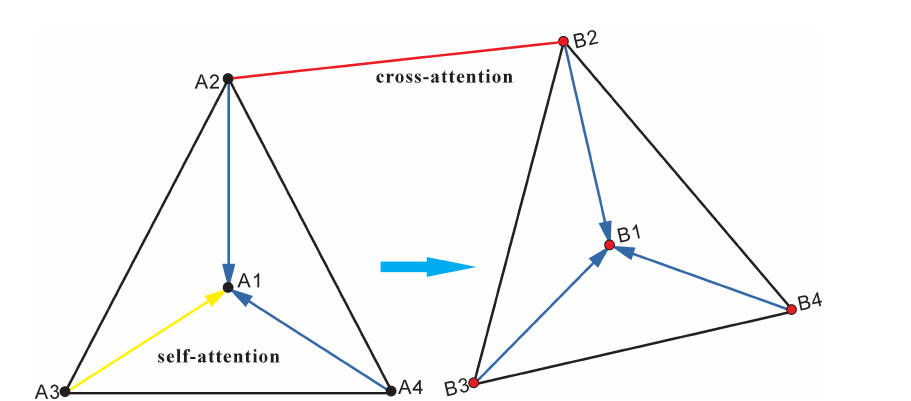
Figure 6. Complete graph of feature points (A1, A2, A3, A4 and B1, B1, B3,